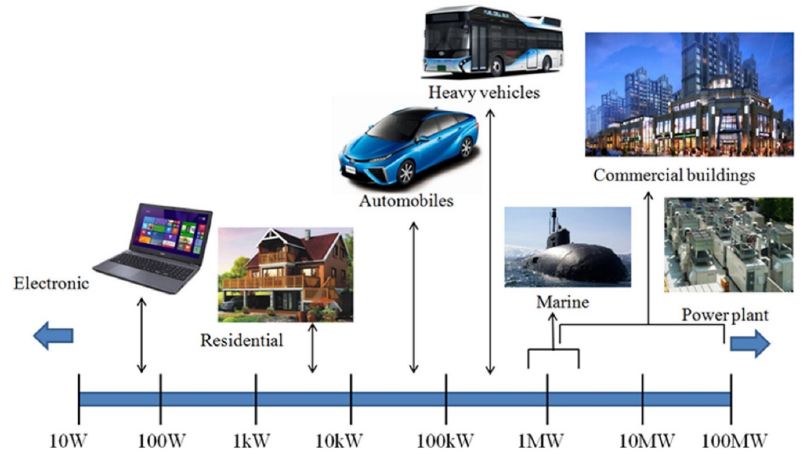
Figure 1. FCs based on a power output scale [17].